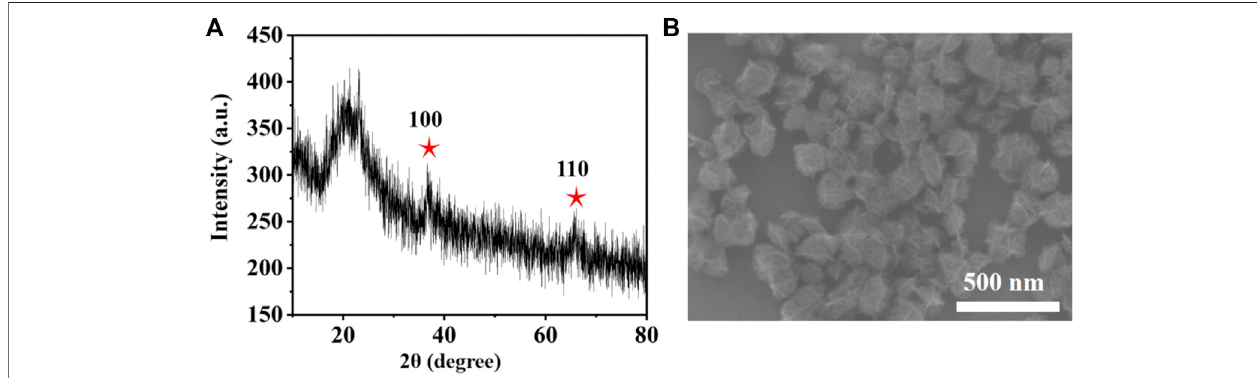
FIGURE 1 | (A) XRD patterns of MONs and (B) HAADF-STEM images.